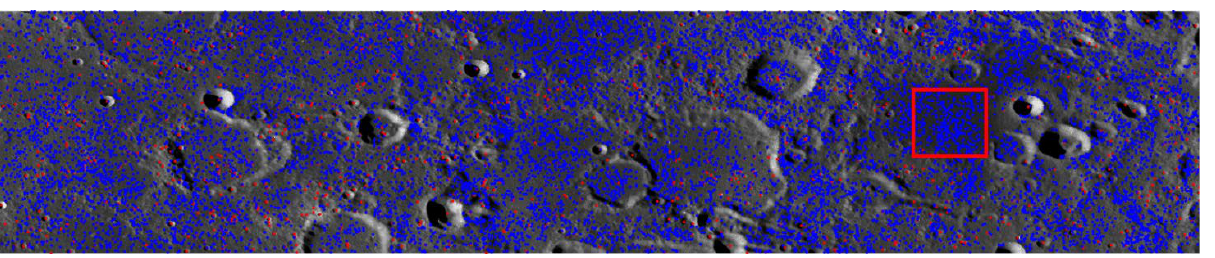
Figure 2. A comparison of the crater detection results between the proposed method and Robbins’ data set